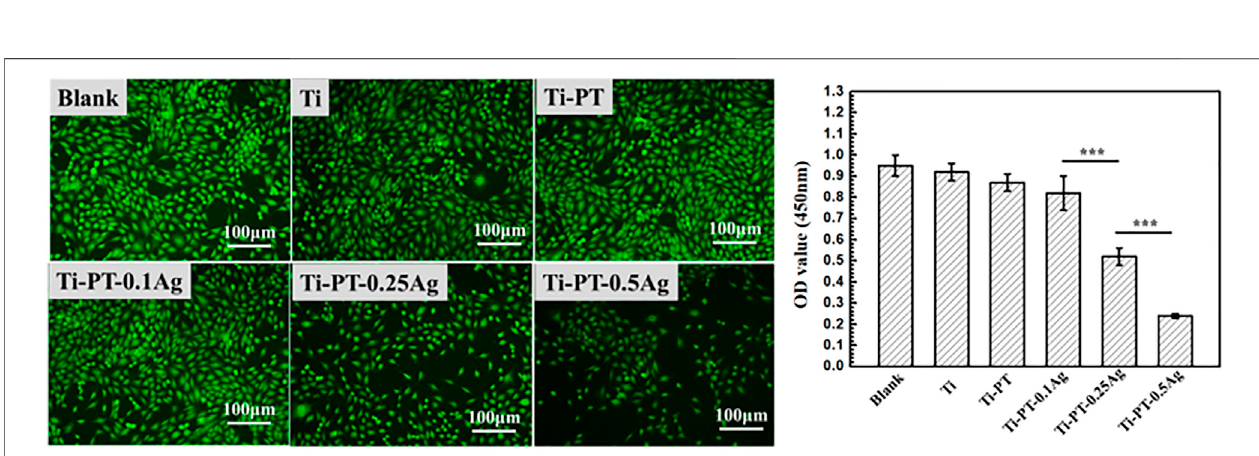
FIGURE 7 | Morphology of mouse fi broblast cells adhered on various samples and the viability of cells attached onto the samples after culture for 1 day (×100 magni fi cation). Data are presented as mean ± SD and analyzed by one-way ANOVA (*** p < 0.001).